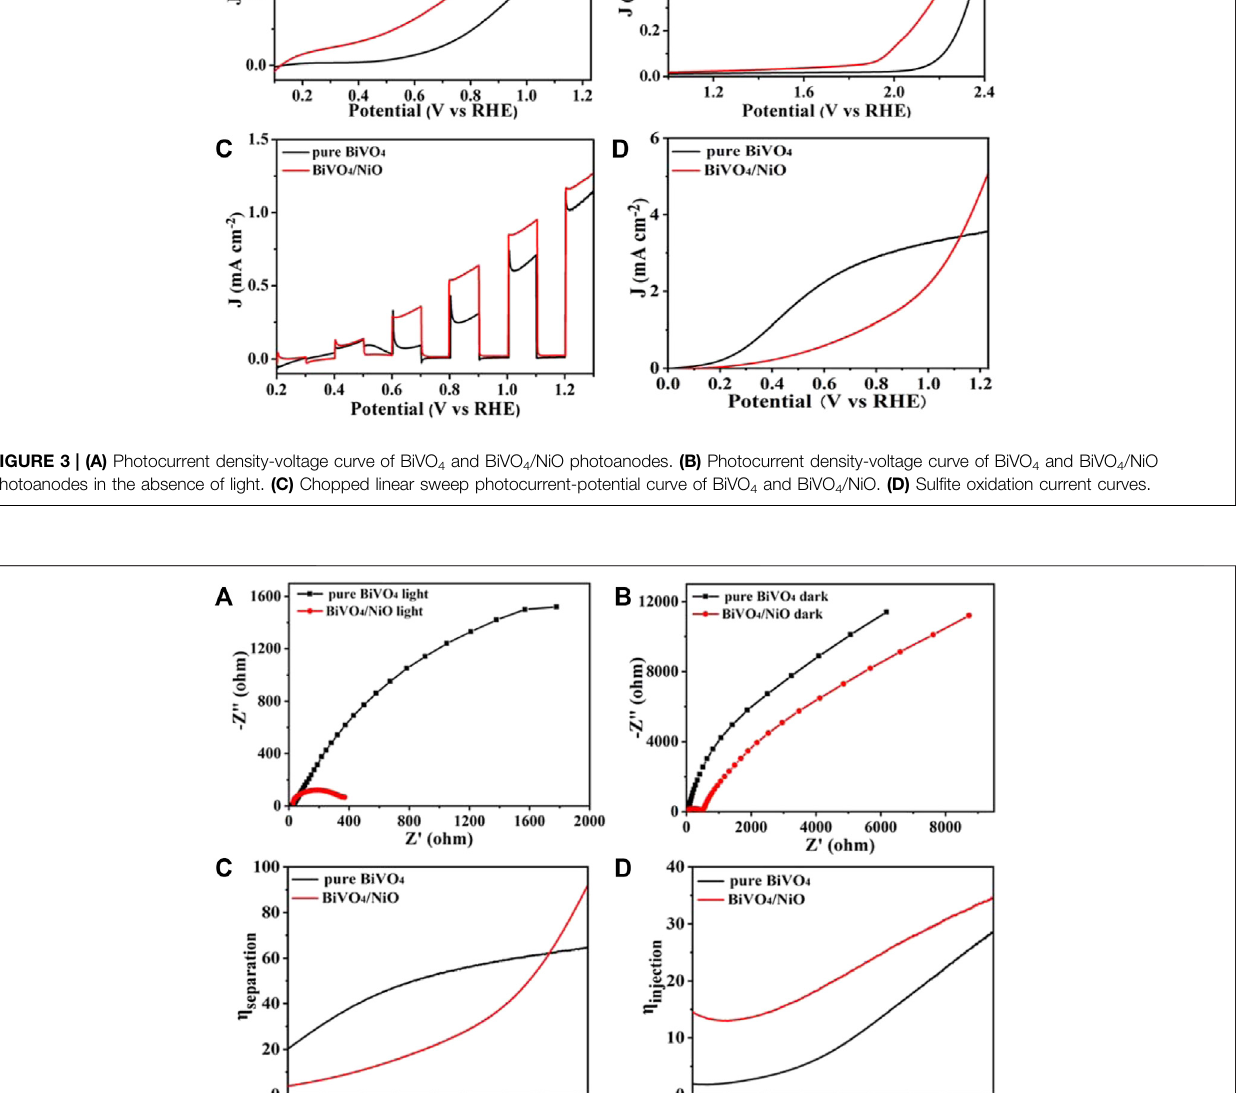
Frontiers in Chemistry |